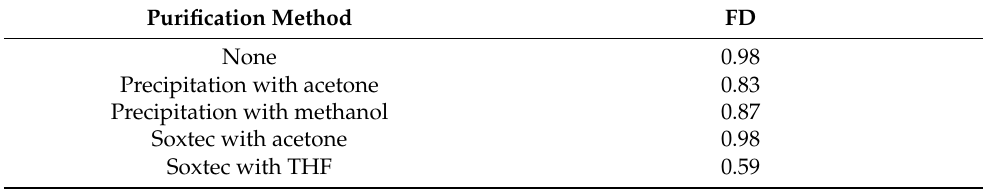
Table A6. Purification